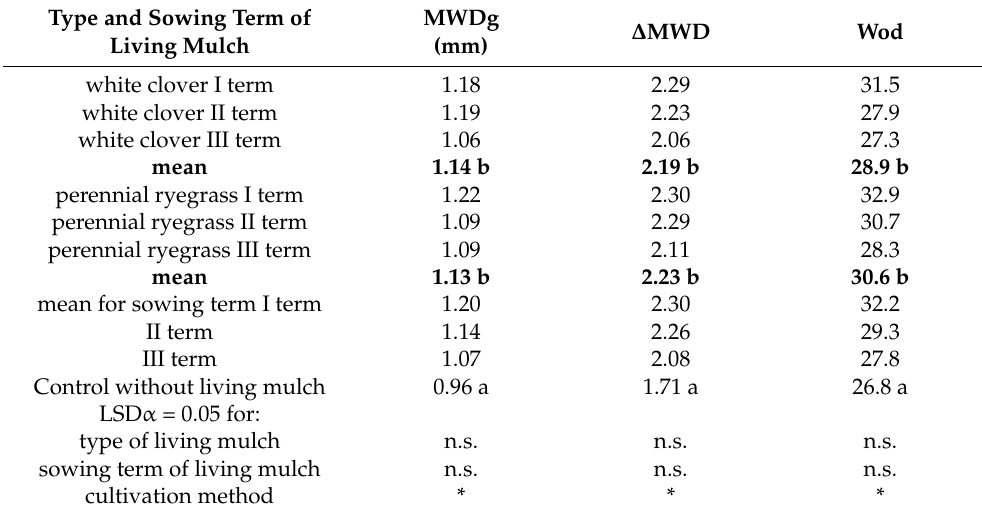
Table 3. The effect of type and sowing term of living mulch on indicators describing wet soil structure status in eggplant cultivation, mean for